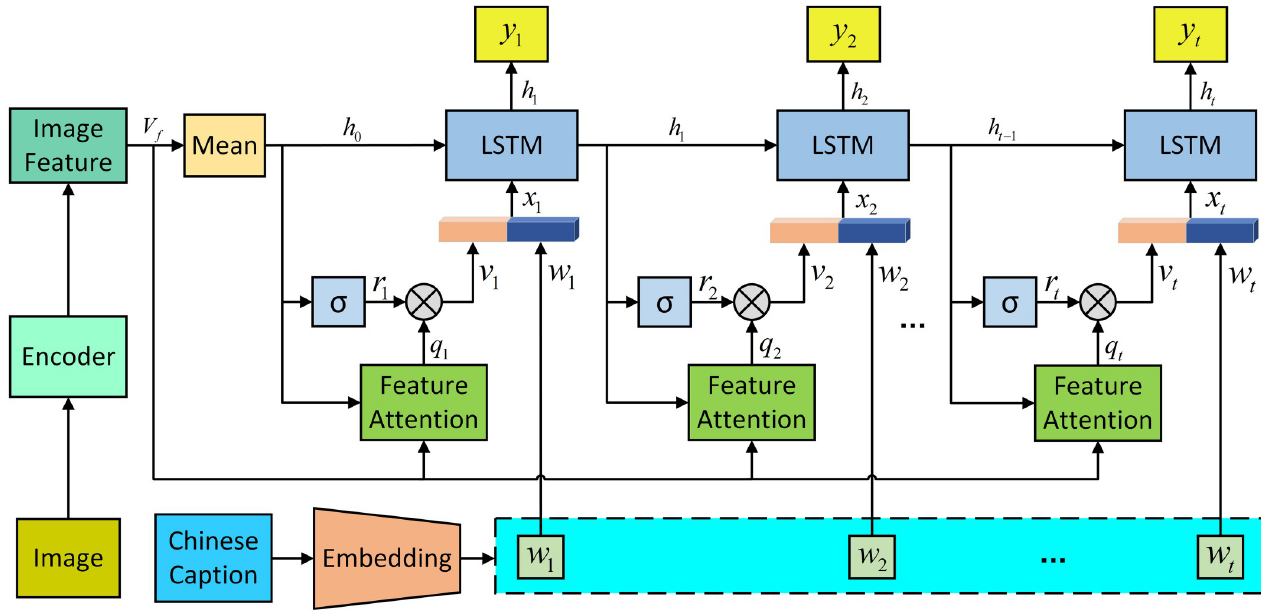
Fig 5. Dynamic adjustment mechanism of image feature attention